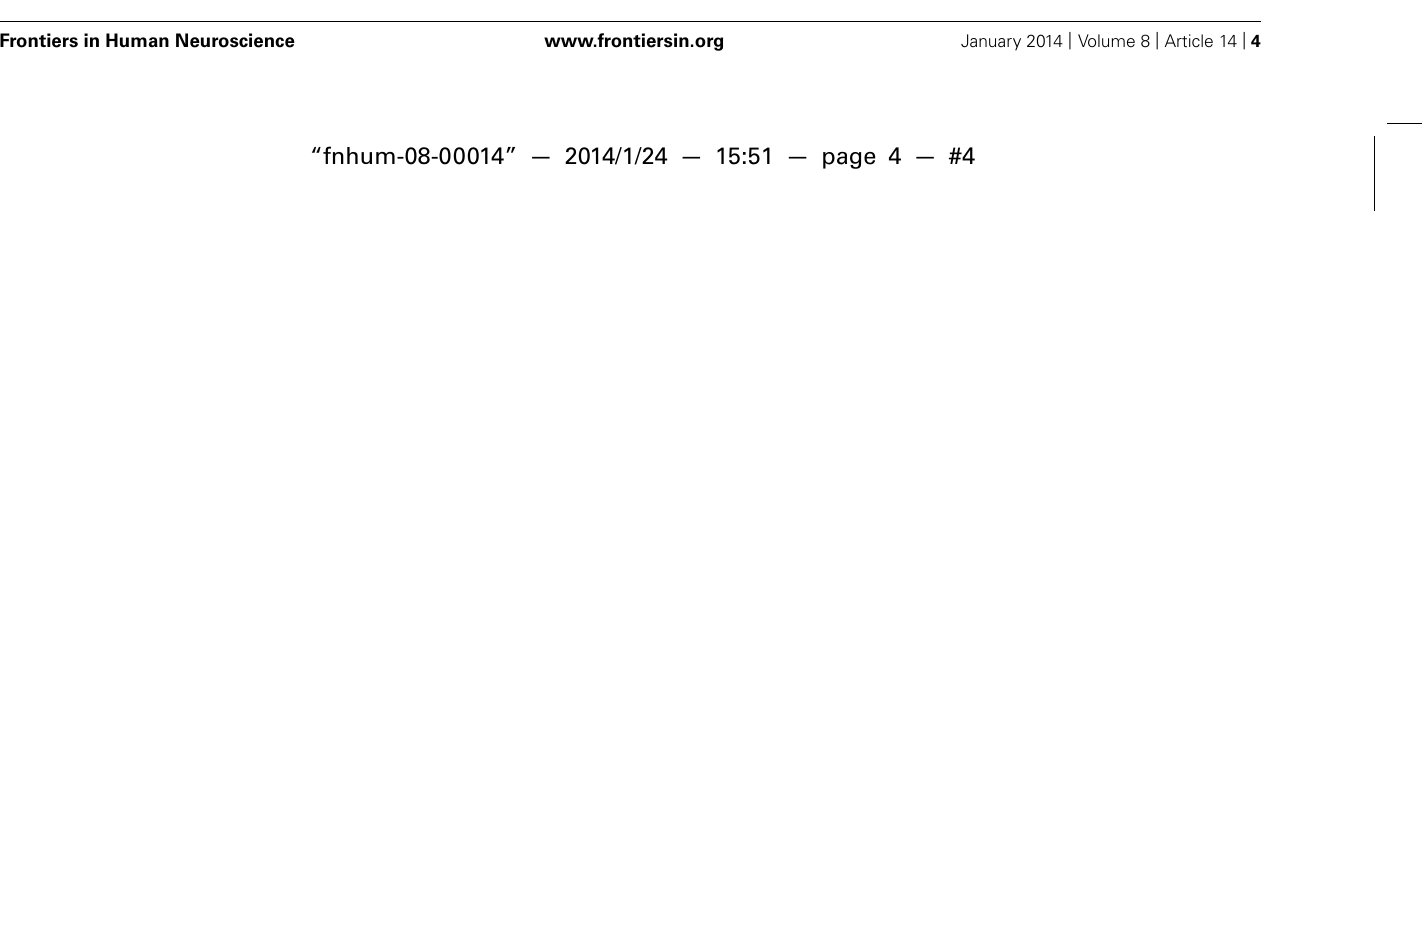
whether or not the circuit was correct and express their level of certainty/uncertainty about their answer. (A) Correct; (B) Incorrect; (C) Correct; (D)